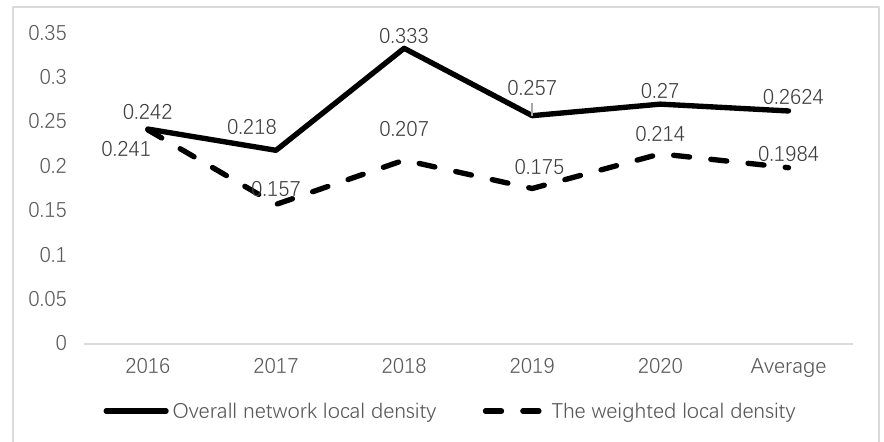
Figure 2. The local density of the food safety risk transfer network.